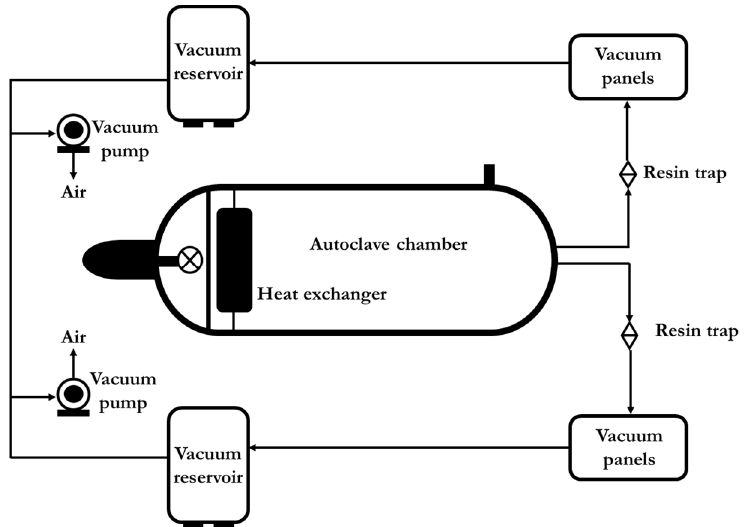
Figure 6. Schematic of vacuum system in a typical autoclave (redrawn from [17]).